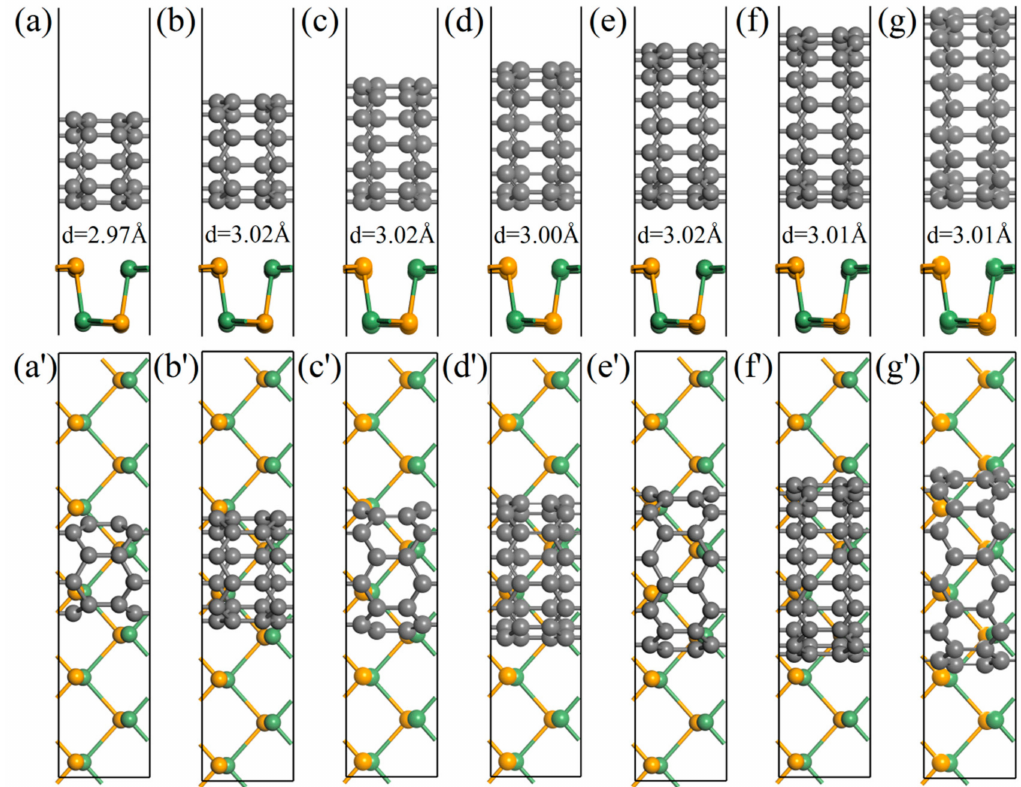
Figure 2. Optimized structures of different CNTs on monolayer GeSe: ( a – g ) and ( a (cid:48) – g (cid:48) ) are side and top view of ( n ,0) CNTs/GeSe ( n = 5–11), respectively. d is the equilibrium spacing between the top Se atomic layer and the annotated wall. Gray, orange, and green spheres represent C, Se, and Ge atoms,